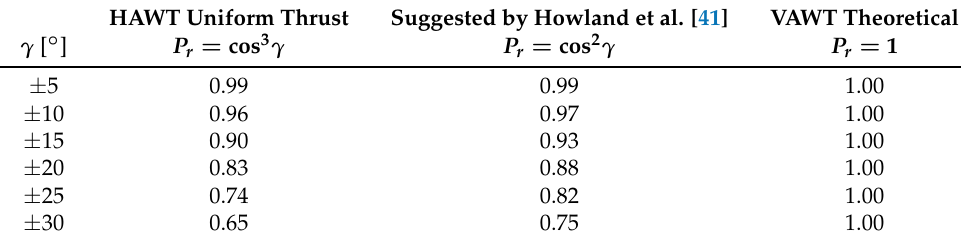
Table 3. Effect of γ in P r for a HAWT and VAWT. For a HAWT, P r is computed with cos 3 γ and with cos 2 γ . The latter is a correction suggested by Howland et al. [41]. HAWT Uniform Thrust Suggested by Howland et al. [41] VAWT Theoretical γ [ ◦ ] P r = cos 3 γ P r = cos 2 γ P r = 1 ± 5 0.99 0.99